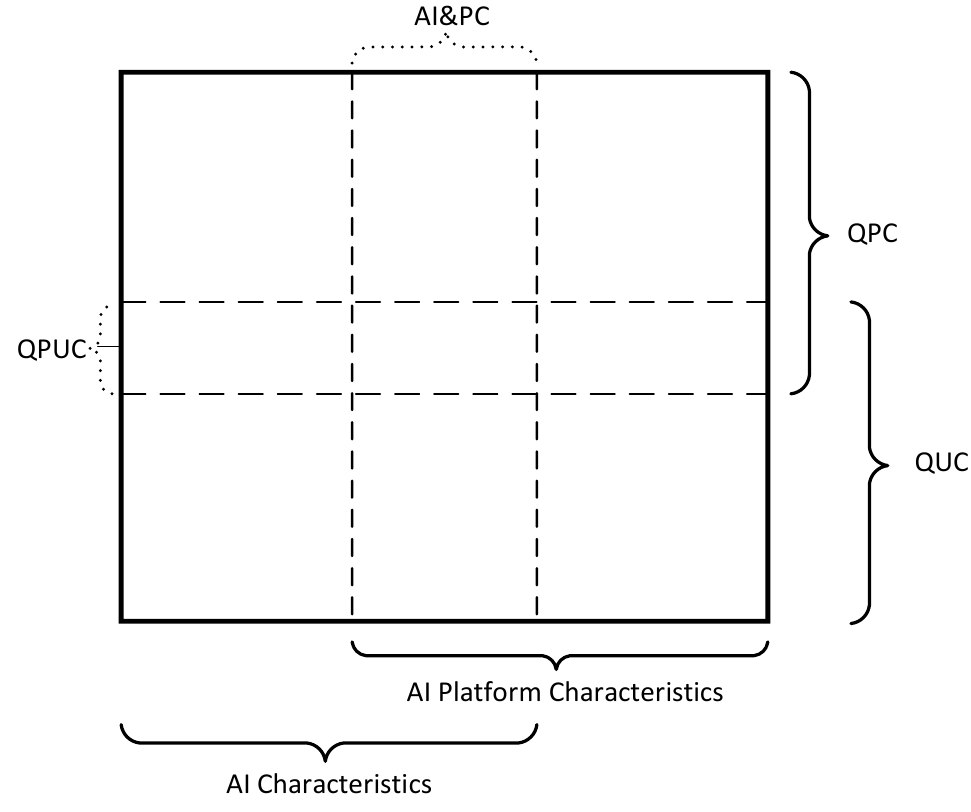
Figure 1. Quality characteristics classification card general view.